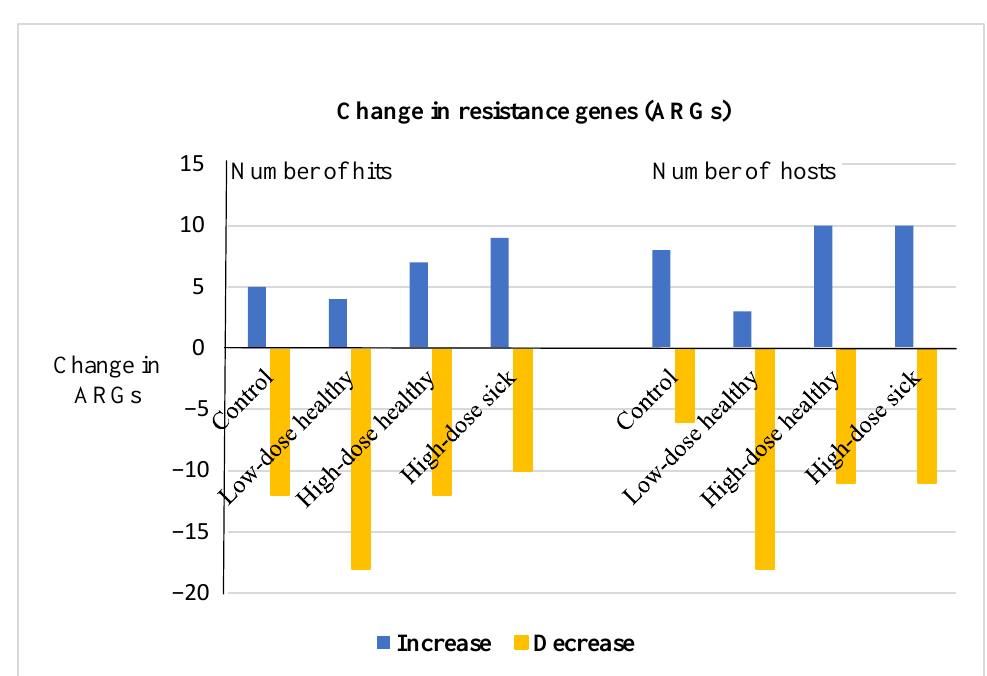
Figure 6. Changes in the copy numbers and the host ranges of ARGs in four groups of the study calves. At least an increase or decrease by 25% was considered in the number of hit changes, while an increase or decrease of one cluster for ARGs with at least two copies was considered for the host range changes. The numbers of clusters were different between pre- and post-treatment samples, but they were normalized to make a reasonable comparison.